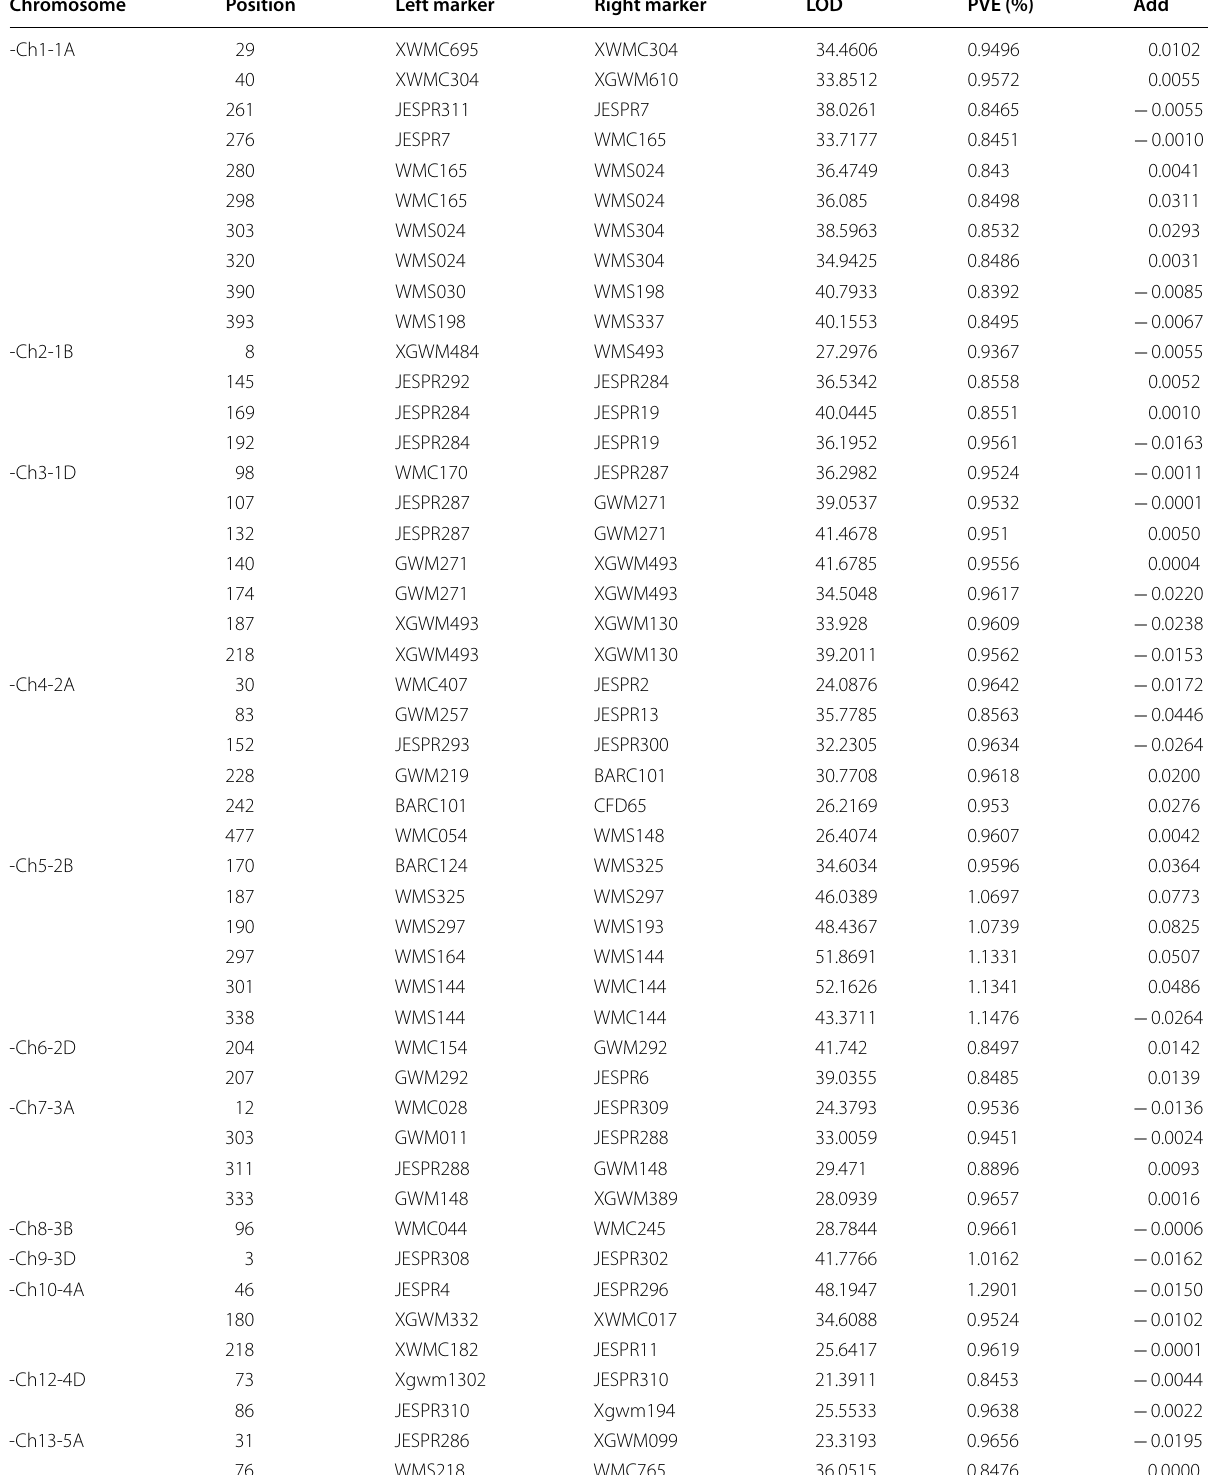
Table 5 Position, characters, and distribution the QTLs related to plant height among nineteen chromosomes out of twenty‑one wheat